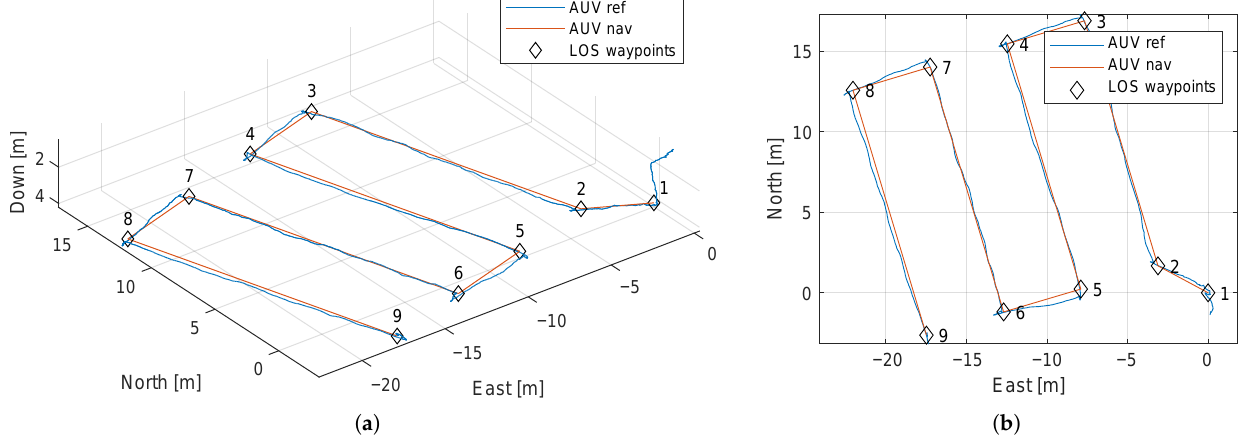
Figure 14. AUV tracking trajectory for the sea trials in NED coordinate system: ( a ) 3D view, ( b ) 2D